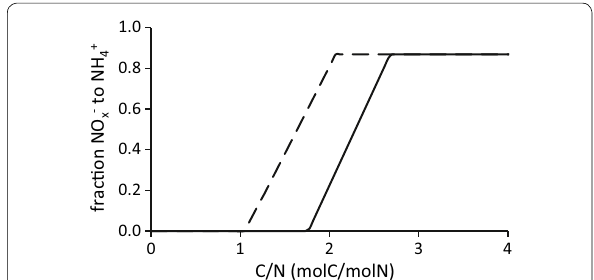
Fig. 3 Predicted ammonium production at different influent acetate:nitrogen ratios in a chemostat fed with nitrite ( dashed line ) or nitrate ( solid line ) as electron acceptor. The ammonia production using nitrate is obtained from the model for our previous study (van den Berg et al. 2016). The shown ammonia concentrations for use of nitrite are an extrapolation of the model